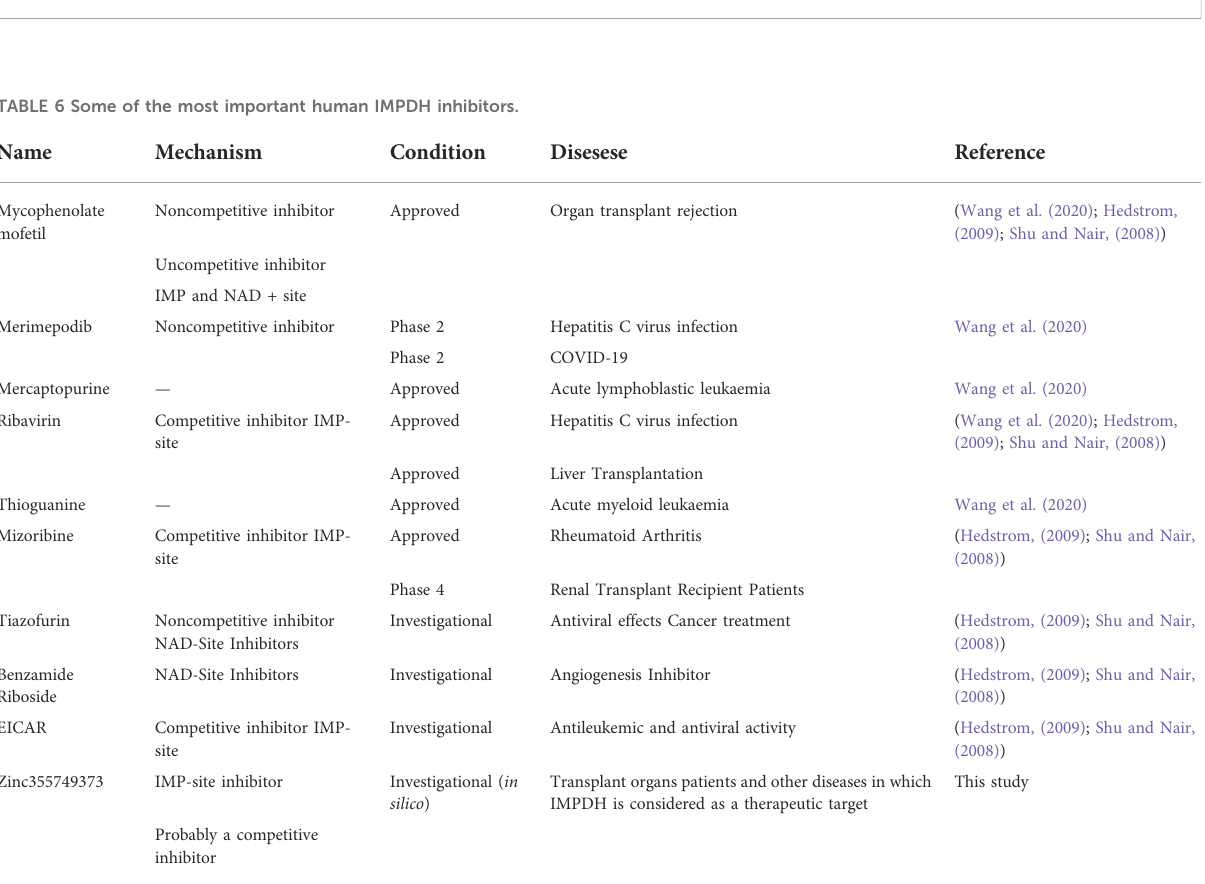
FIGURE 8 MM/PBSA free energies of 1hIMPDH-Zinc355749373 (A) and 2hIMPDH-Zinc355749373 (B) complexes in tetrameric form calculated from molecular dynamics trajectory